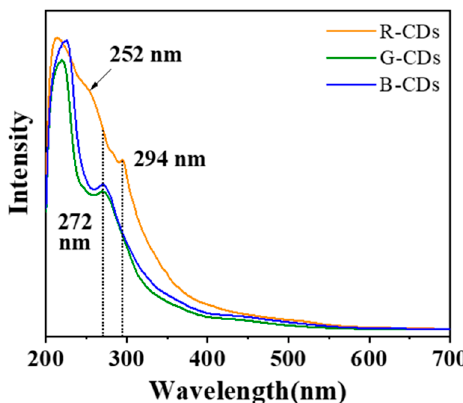
Figure 2. UV–vis absorption spectra of the three CDs (0.1 mg/mL) in Figure 2. UV ‒ vis absorption spectra of the three CDs (0.1 mg/mL) in ethanol.